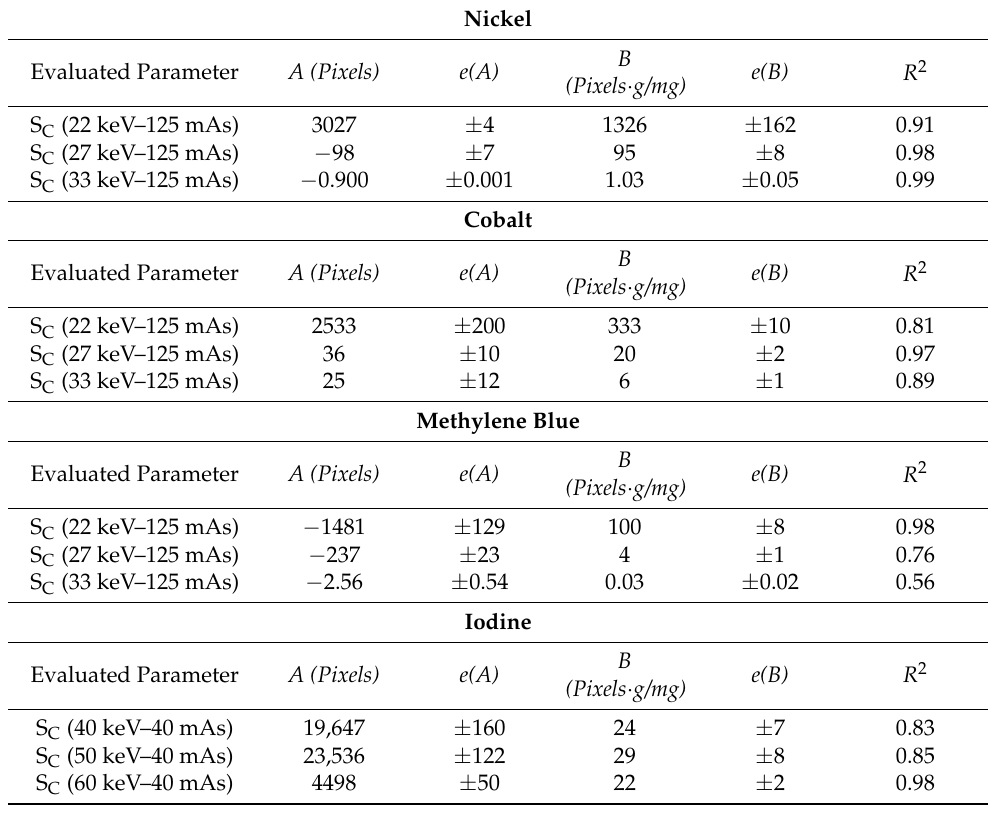
Table 8. Fitting parameters found for q e value versus Sc parameter (XRA) for each adsorbed molecule or ion.